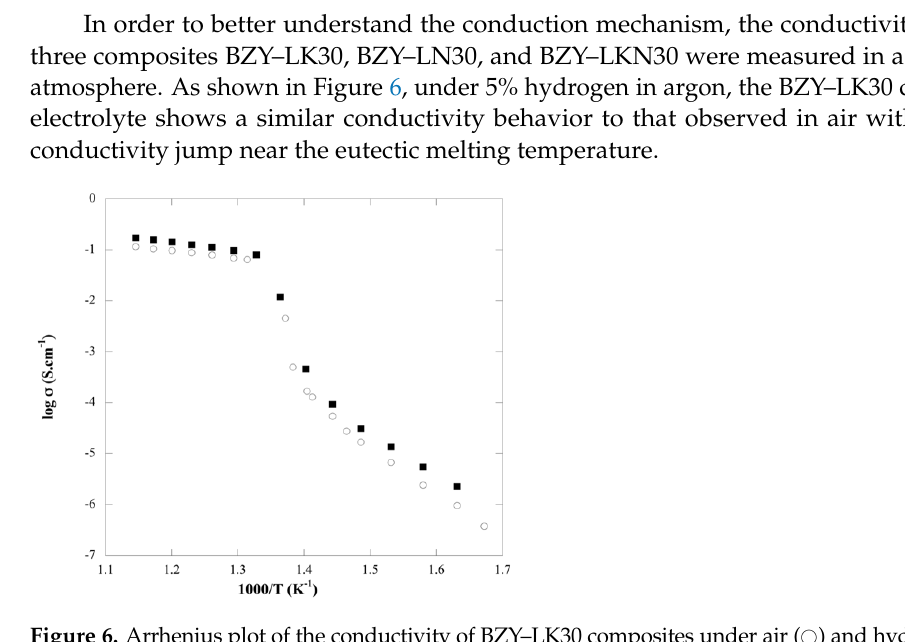
) and hydrogen ( (cid:4) (cid:35)